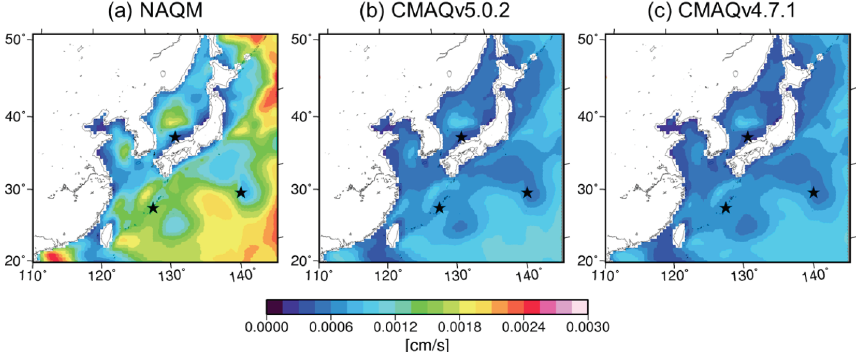
Figure 8. Comparison of the spatial distribution of dry deposition velocity of O 3 in East Asia simulated by (a) NAQM, (b) CMAQ 5.0.2, and (c) 4.7.1.